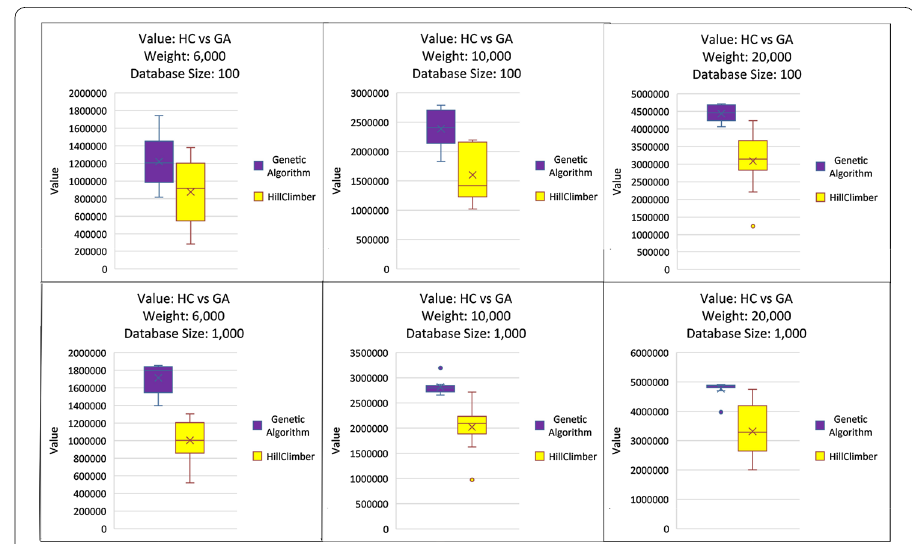
Fig. 3 Genetic Algorithm and Hill Climber: Compares GC (Population: 25) Values against HC Values